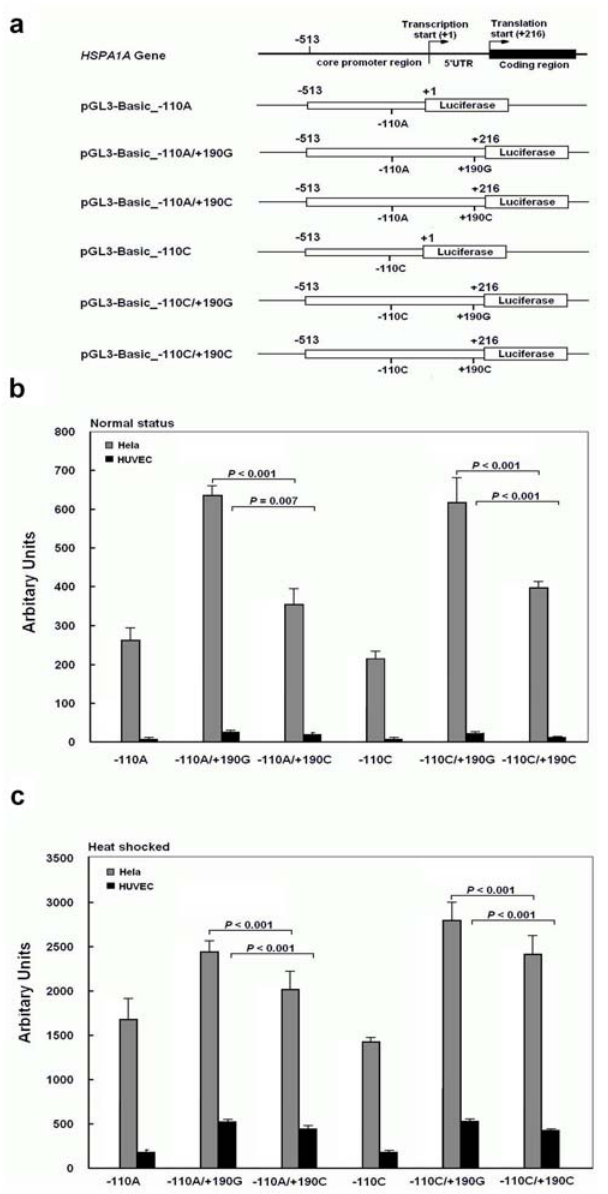
Figure 1. Effects of 2 110A/C and + 190G/C polymorphisms on luciferase activity. (a), Schematic representation of HSPA1A gene 5 9 flanking region and reporter constructs. (b) to (c), the six reporter constructs and empty pGL3-Basic was transfected into Hela and HUVEC cells under normal culture (b) or heat shocked conditions (c). All constructs were cotransfected with pRL-SV40 to standardize the transfection efficiency. Fold increase of luciferase activity was measured by defining the activity of the empty pGL3-Basic vector as 1. The RLA values are presented as means, and the T bars represent standard deviations (SD). Mean 6 SD from